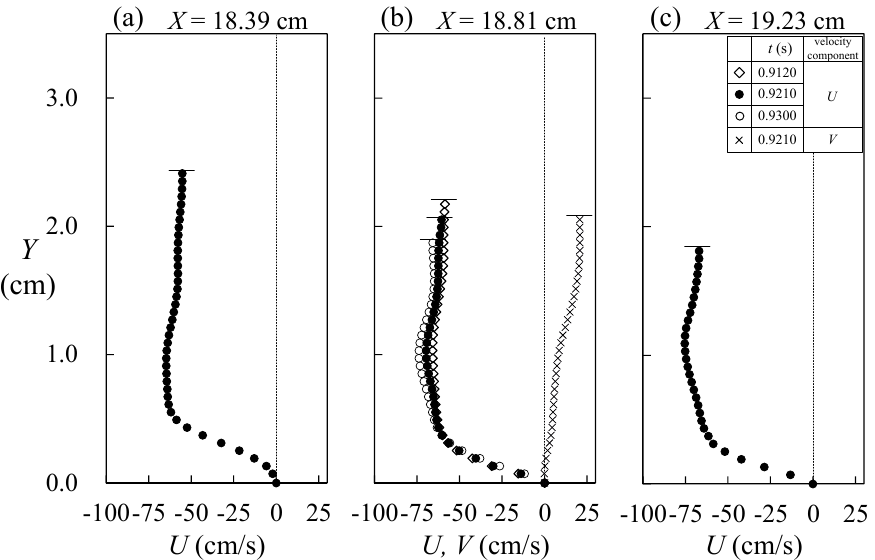
Figure 10. ( a – c ) The velocity profiles, U ( Y ), measured at X = 18.39, 18.81 and 19.23 cm for t = 0.9210 s, respectively. Note that two velocity profiles, U ( Y ), for t = 0.9120 and 0.9300 s as well as one velocity profile, V ( Y ), at t = 0.9210 s are also included in ( b